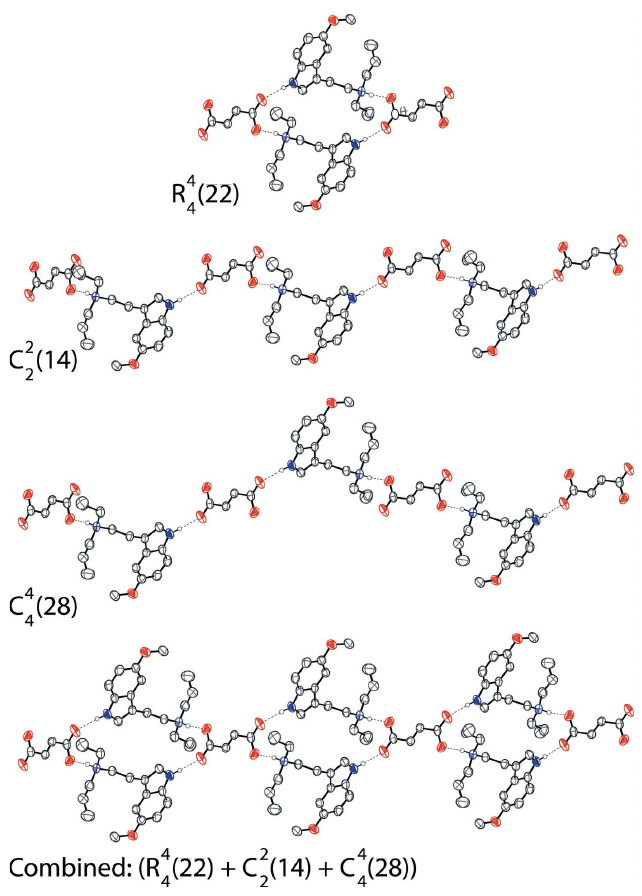
Figure 3 The hydrogen-bonding network along [111], which consists of R 4 (22) 4 rings that are joined together by two parallel C 2 (14) and C 4 (28) chains. 2 4 The three components described in graph-set notation and the combined chain are shown. Displacement ellipsoids are drawn at the 50% probability level. Hydrogen atoms not involved in hydrogen bonding are omitted for clarity. Hydrogen bonds are shown as dashed two fumarate dianions are joined together through the N— H (cid:2) (cid:2) (cid:2) O hydrogen bonds to form rings with graph-set notation R 4 (22) (Etter et al. , 1990). The rings are joined together by two 4 parallel chains along [111]. These chains have graph-set (14) and C 4 (28). The chains and rings are shown in notation C 2 2 4 Fig. 3. The hydrogen bond donor–acceptor distances of 2.5669 (16) A˚ and 2.7729 (17) A˚ indicate strong hydrogen bonds, with the N2—H2 (cid:2) (cid:2) (cid:2) O3 bond being stronger due to a charged donor and acceptor (Desiraju & Steiner, 2001).